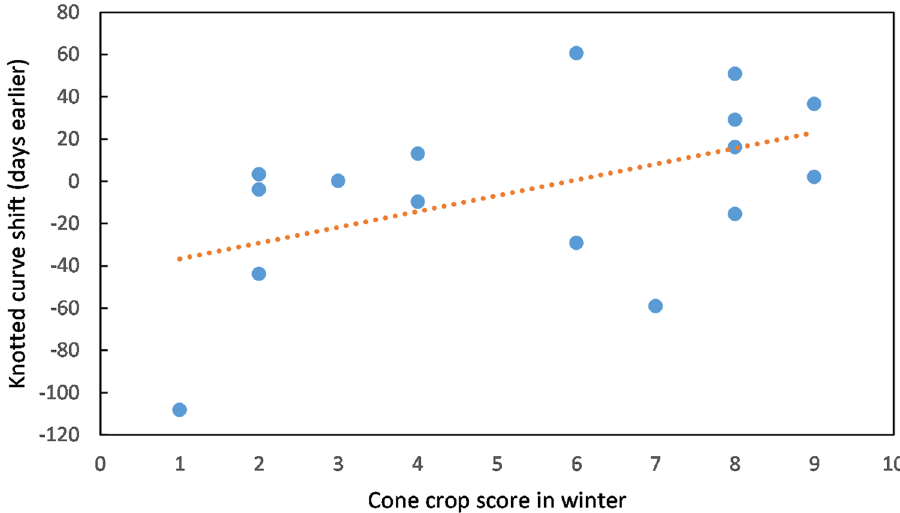
Figure 4. Cone crop impact on timing of sex ratio change. Number of days earlier in the year that changes in sex ratio in catches occurred, as a function of cone crop score of the previous winter. Data for 2005–2020. R 2 = 0.2485.